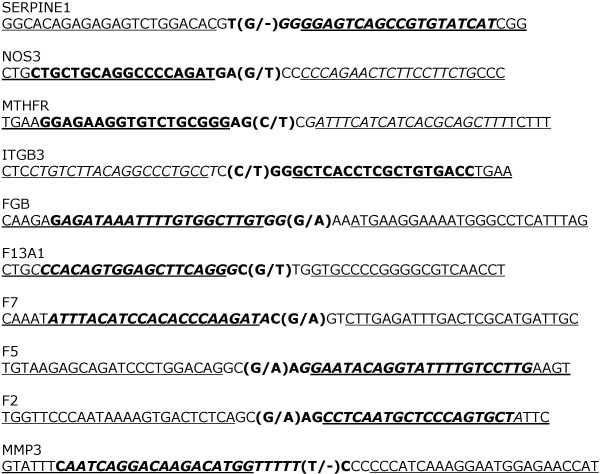
Sequences of all PCR amplicons used for PrASE. Inner multiplex PCR primers are underlined. The placement of PrASE and Pyrosequencing primers are indicated in bold and italic respectively. Note that the forward strand sequences are displayed hence the actual sequences of primers are reverse and complementary where appropriate.